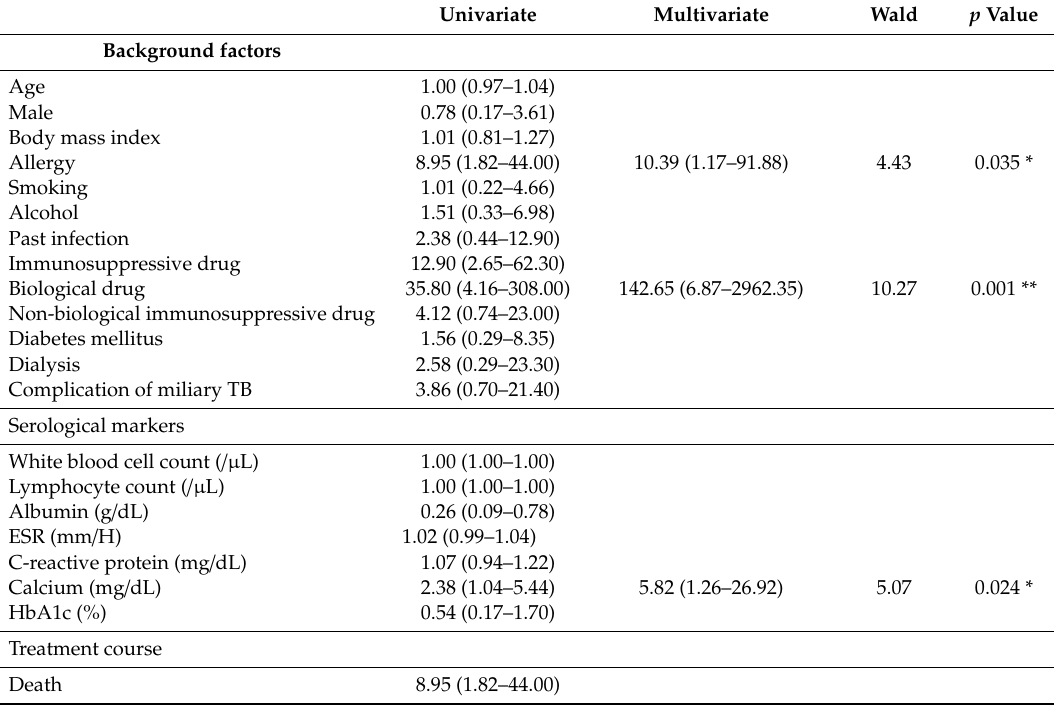
Table 4. Univariate or multivariate analysis for IRIS development.